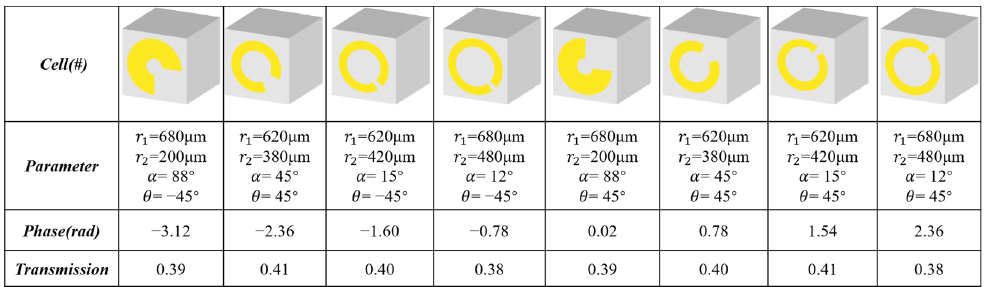
Figure 4. Phase response of the single-layer metal C-shaped SRRs. ( a ) Transmission coefficients and phase responses for eight discrete unit cell structures; ( b ) relationship between the lateral distance of PDMS substrate from the origin point and the phase before and after stretching. Table 1. Design results of dynamically tunable meta-lens unit cell structure parameters of stretchable substrate single-layer metal structure.